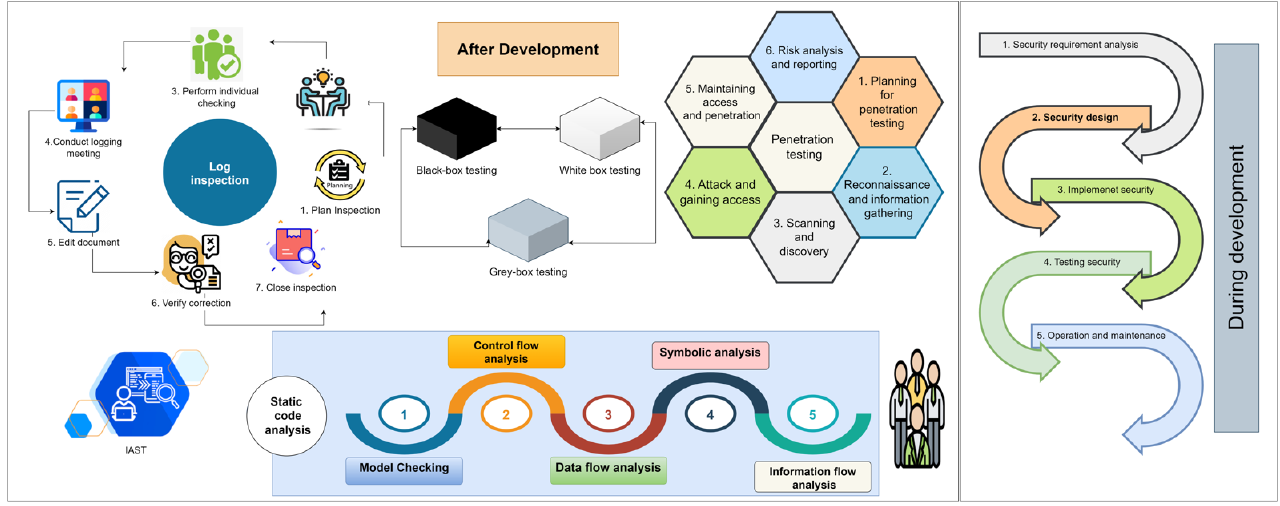
Figure 1. An insight into security verification